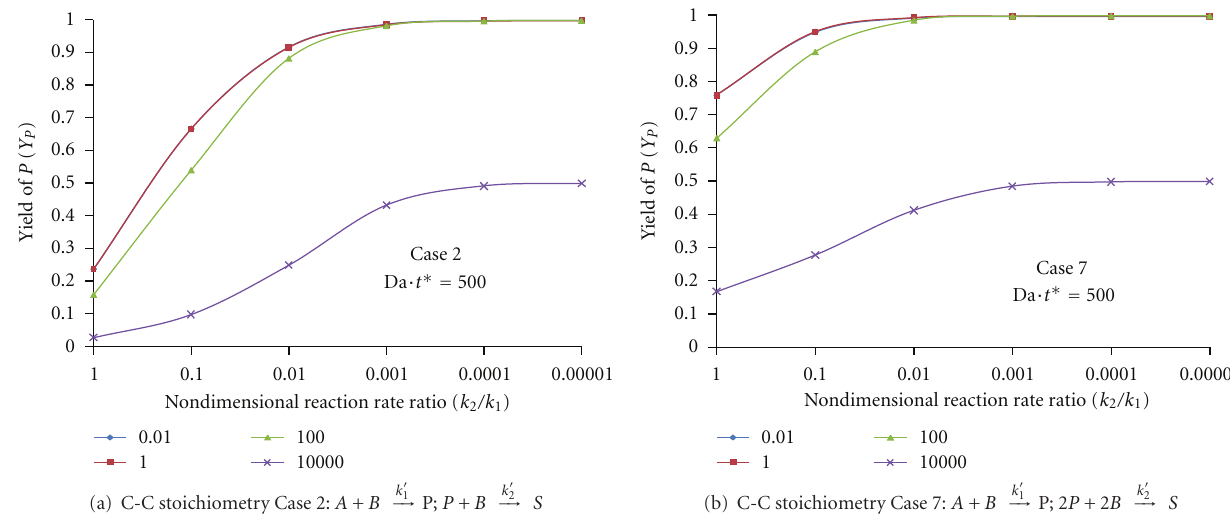
Figure 3: Plots of Yield of P versus k 2 / k 1 for two sample C-C stoichiometries. The curves represent the di ff erent Da. Curves for Da = 0 . 01 lie exactly under the curves for Da = 1.